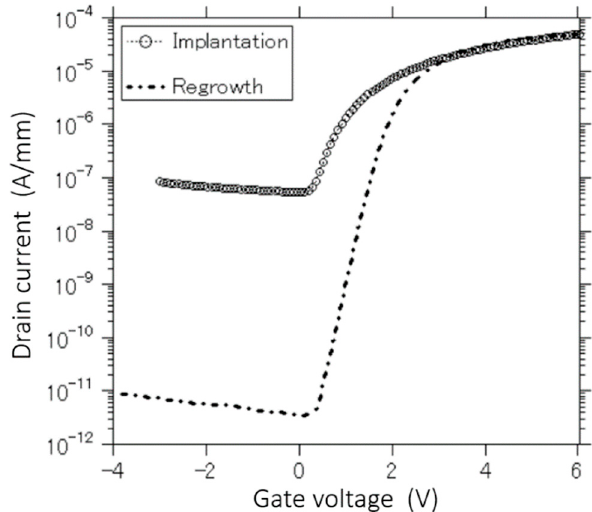
Figure 4. Transfer I d –V g characteristics.